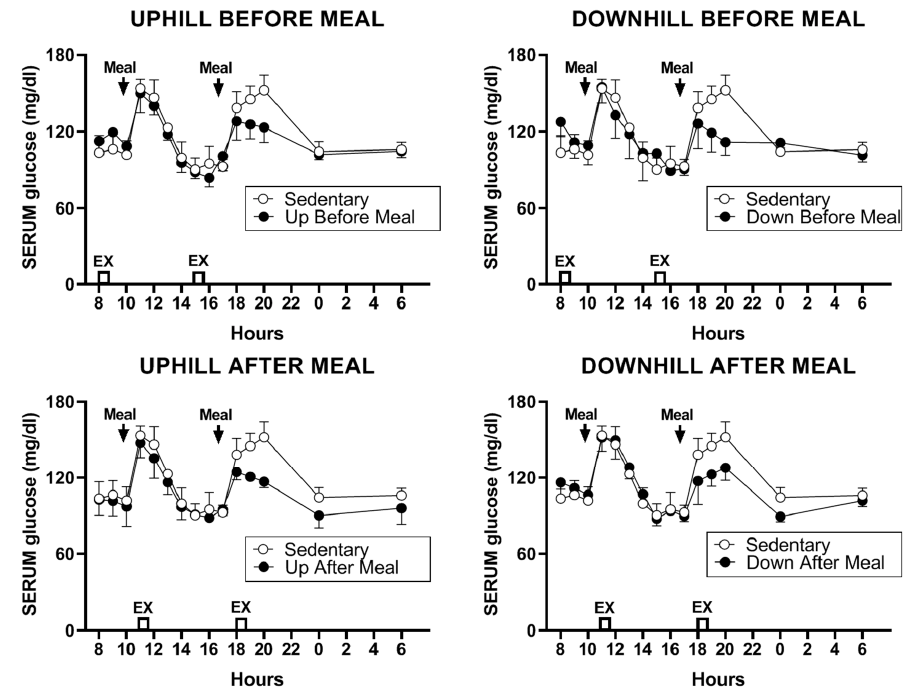
Figure 7. The change in serum glucose concentration in the four exercise relative to sedentary trials.